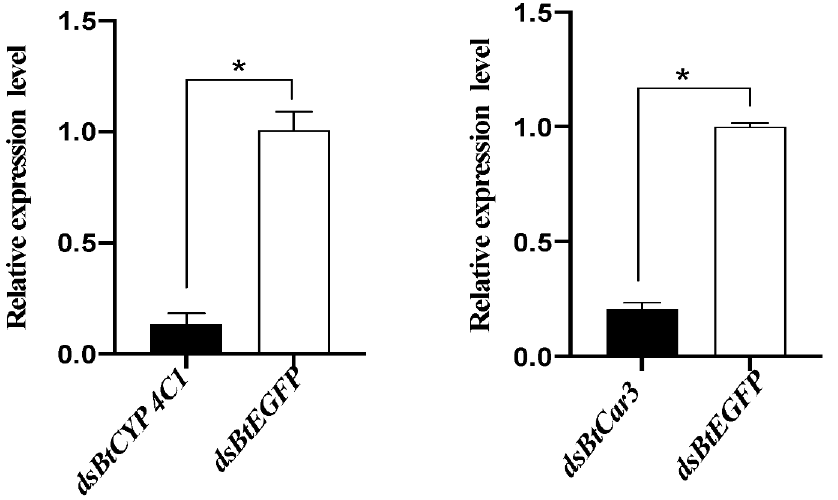
Figure 3. Effects of dsRNA treatments on mRNA expression in the Bemisia tabaci . Symbol * indicates significant differences at p < 0.05.